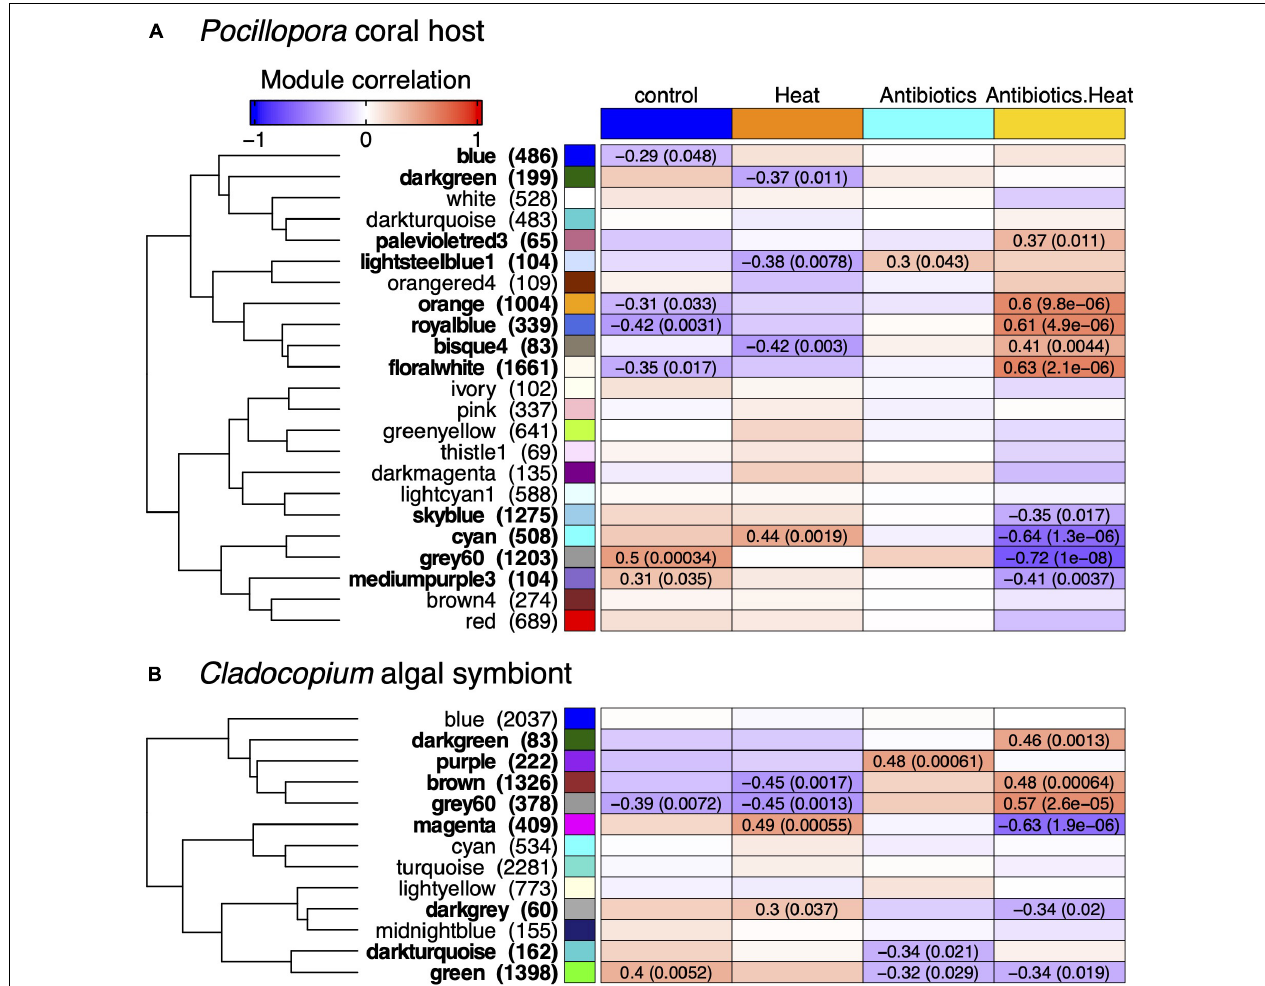
FIGURE 4 | WGCNA reveals (A) Pocillopora and (B) Cladocopium co-expressed gene modules correlated to experimental treatments. The heatmap color represents the correlation coefficient of module eigengene expression to each treatment ranging from blue for negative correlation (–1) to red for positive correlation (+1), and the Pearson correlation coefficient and p -value is listed in each cell with a significant correlation ( p < 0.05). The eigengene hierarchical clustering dendrogram is depicted to the left of the heatmap, and the number of genes in each module is listed in parentheses next to the module label. There are 12 Pocillopora and 8 Cladocopium modules that are significantly correlated to one or more treatments.